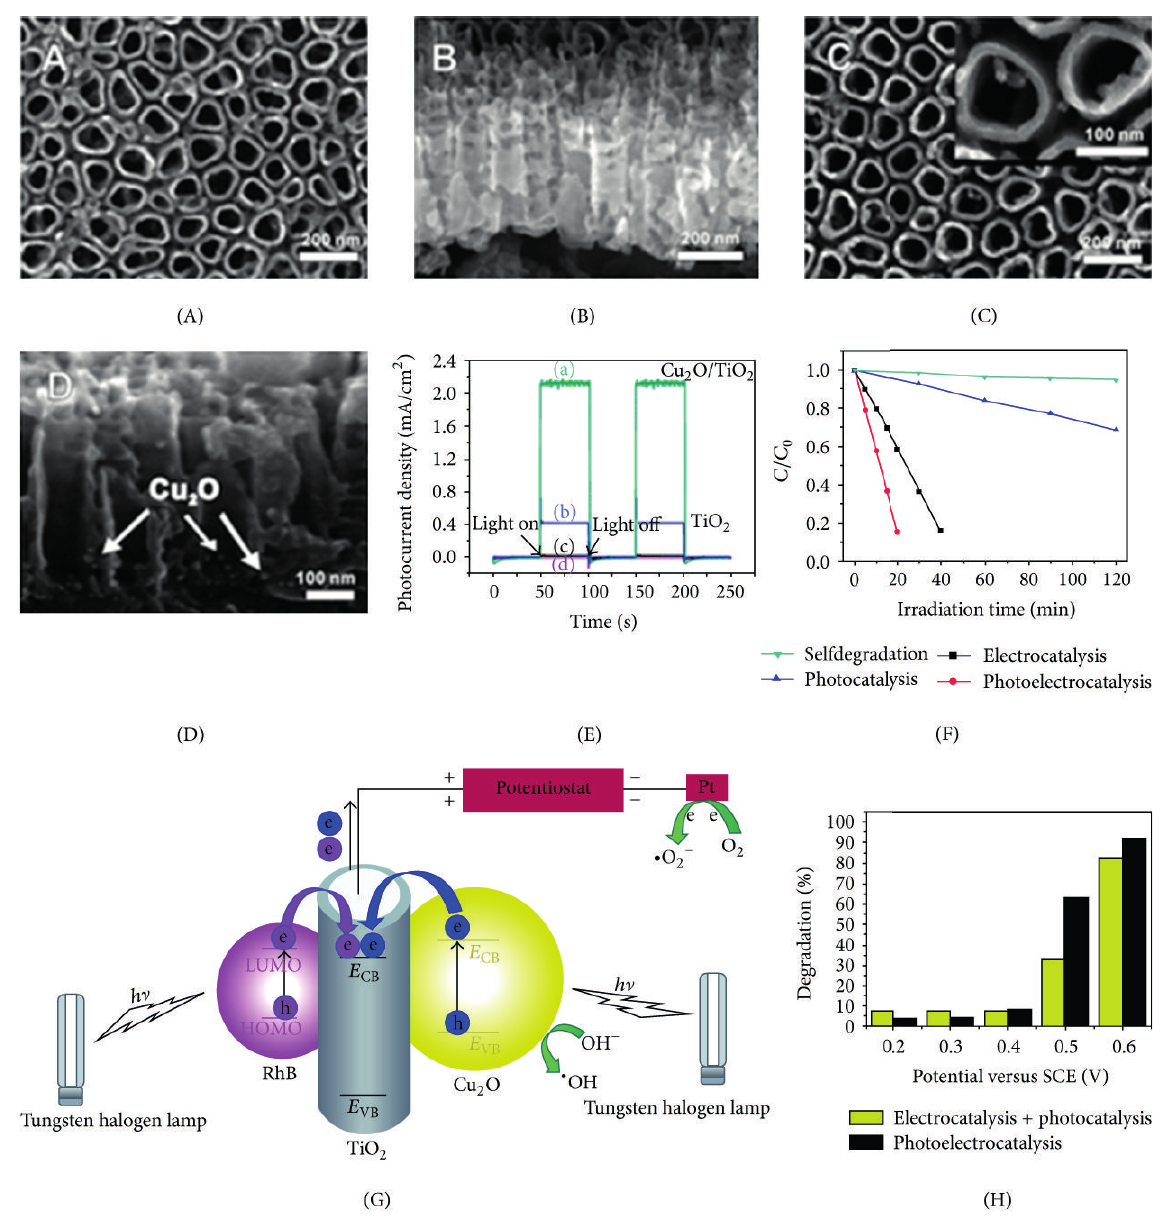
Figure5:SEMimageofTNAs(A,B)andCu 2 O/TiO 2 NTAs(C).TEMimageofCu 2 O/TiO 2 NTAs(D).(E)PhotoresponseofCu 2 O/TiO 2 NTAs (a, c) and TNAs (b, d) with (a, b) or without (c, d) a bias potential of 0.5 V (versus SCE) under one sun visible light irradiation. (F) Comparison of photocatalytic, electrocatalytic, and photoelectrcatalytic degradation of RhB under visible light irradiation for Cu 2 O/TiO 2 NTAs. (G) Schematic illustration of photoelectrocatalytic degradation of RhB under visible light irradiation. (H) Comparison of RhB degradation efficiency using Cu 2 O/TiO 2 NTAs in the process of photoelectrocatalysis (right) with the sum of photocatalysis and electrolysis